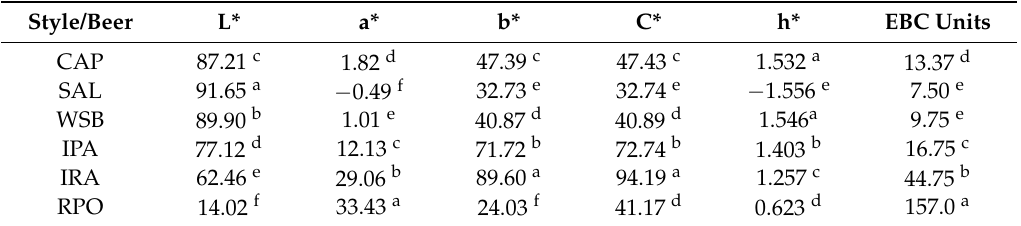
Table 3. Color parameters of craft beers. L* (luminosity), C* (chroma), h* (hue) and EBC (European Brewery Convention) units. Classic American pilsner (CAP), standard American lager (SAL), weissbier (WSB), American India pale ale (IPA), Irish red ale (IRA), and robust porter (RPO). Different letters in the same column indicate significant differences between groups of beers ( p < 0.05, ANOVA followed by post-tests).